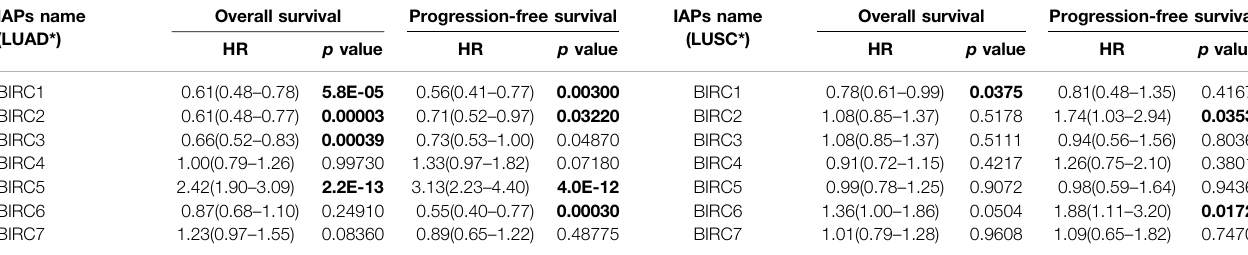
TABLE 2 | Correlation of IAPs mRNA expression and prognosis in NSCLC by Kaplan – Meier